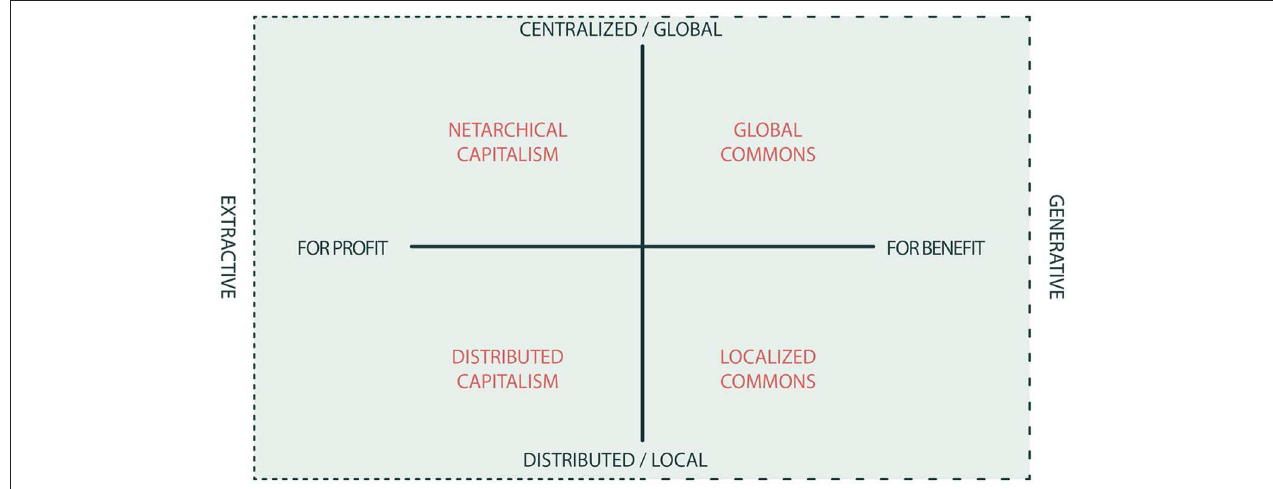
FIGURE 1 | Generative vs. extractive economies: four competing socio-technological value systems (used with permission. Graphic by Michel Bauwens, published in “P2P Accounting for Planetary Survival,” P2P Foundation, upcoming 2019). This framework was first introduced in Kostakis and Bauwens (2014) and was re-worked and published in the form used in this article in Bauwens and Pazaitis (2019, p.